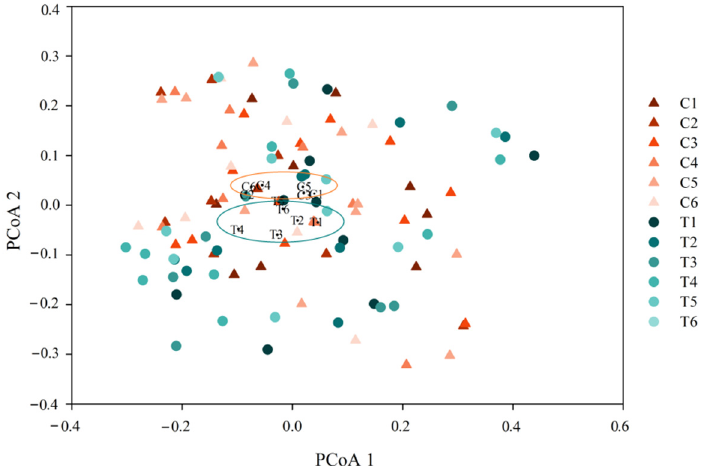
Figure 3. Principal coordinate analysis of intestinal microbiota in NS-NSCLC patients between C and T for each treatment.